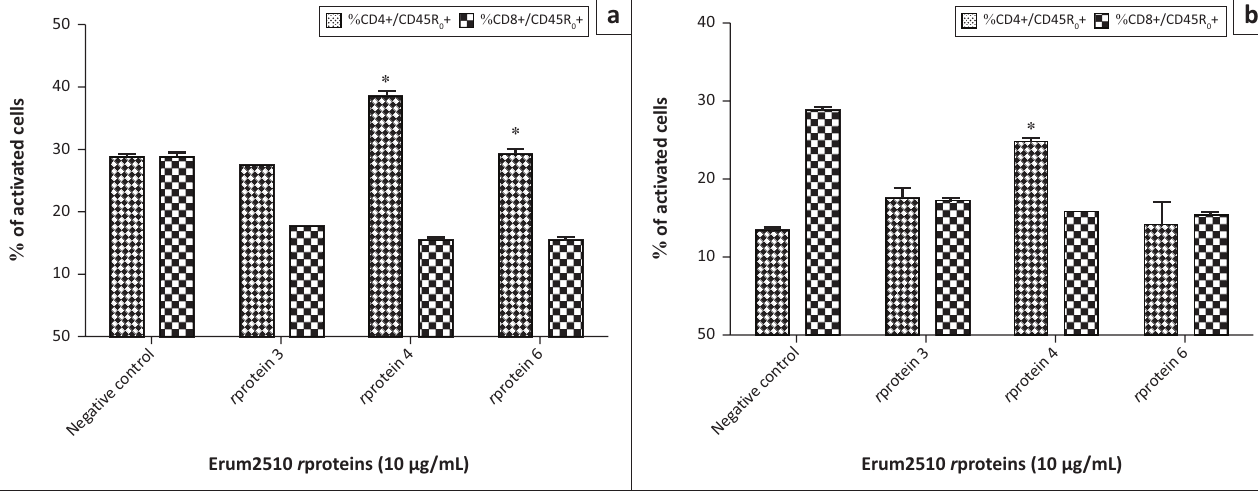
FIGURE 4-A1: Average percentage of peripheral blood mononuclear cells from s6823 (a) and sM2 (b) that stained positive for CD4 and CD45RO; and CD8 and CD45RO expression markers after stimulation with Erum2510 rproteins 3, 4 and 6. Unstimulated peripheral blood mononuclear cells was included as negative control. peripheral blood mononuclear cells were stimulated with 10 µg per ml protein and incubated for 72 h after which the percentage of cells was determined by flow